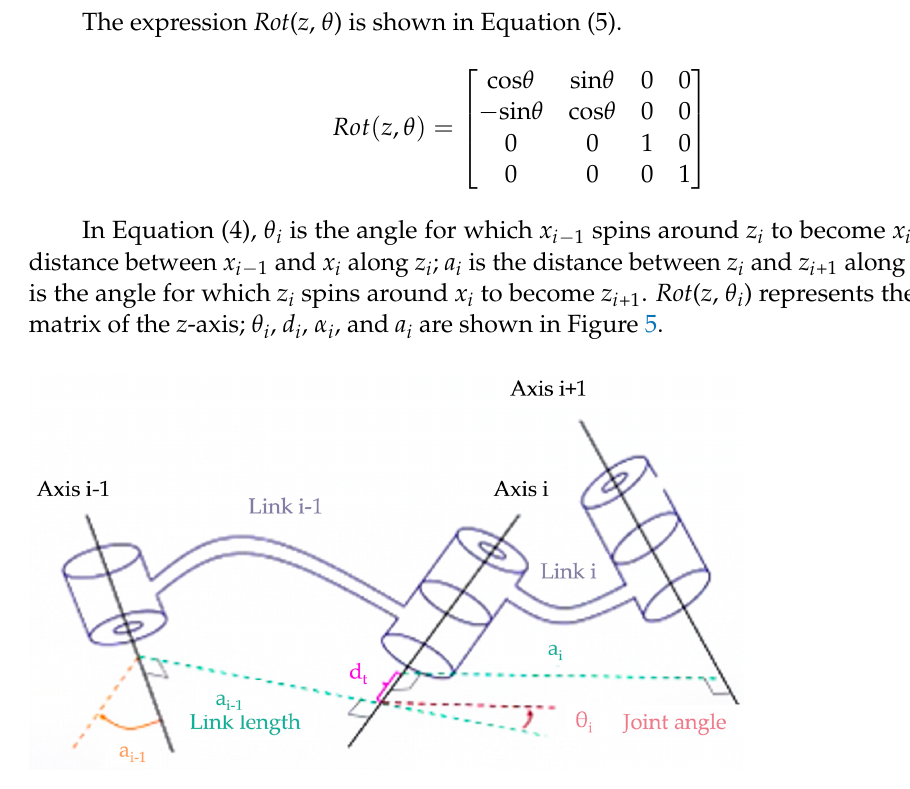
Figure 4. The pose diagram of the UR10 robot.